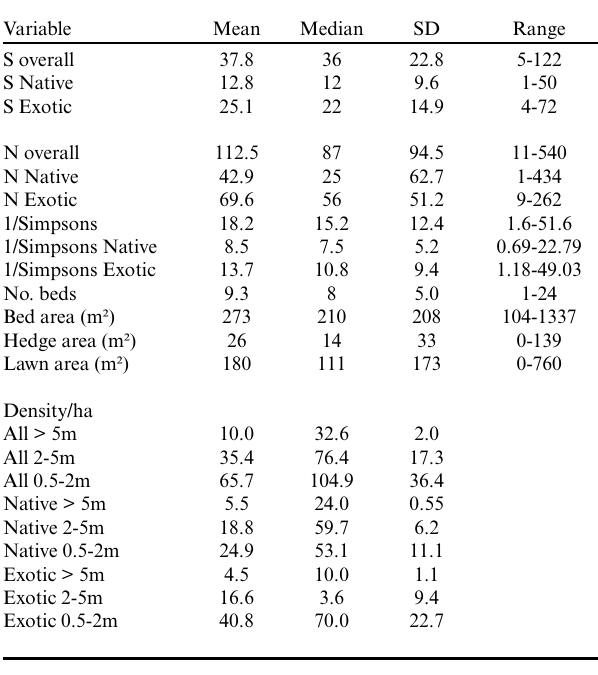
Fig. 2 . Species accumulation plots of all, native, and exotic woody species (solid dot = observed S, solid triangle = Jackknifed, and open square = bootstrapped values) across the 55